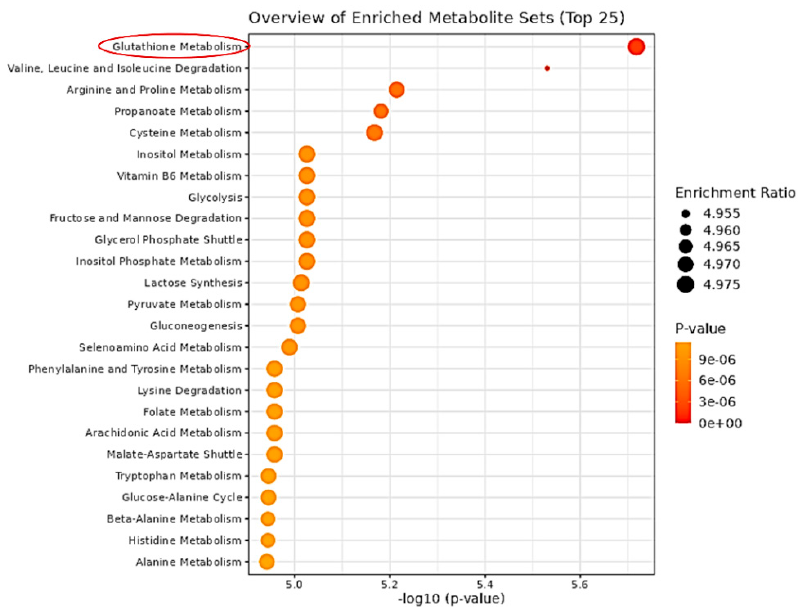
Figure 2. Overview of metabolite sets enrichment: Quantitative Enrichment Analysis (QEA) algo-